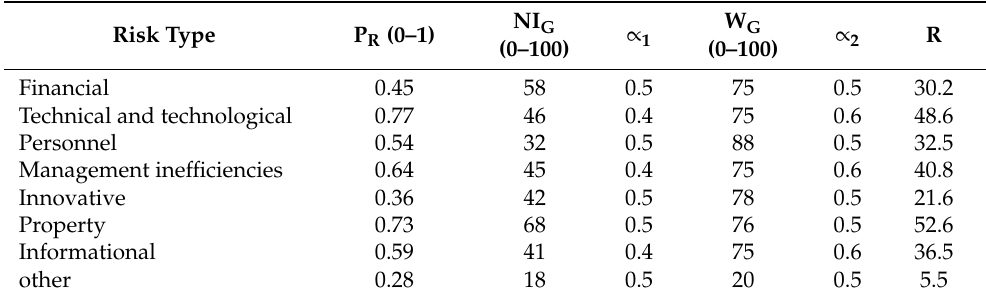
Table 4. The results of an expert assessment of the internal risks of enterprises of the “Valley of Mechanical Engineering” cluster, 2020